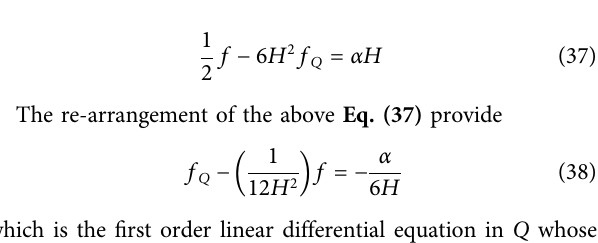
FIGURE 2 | Plot of reconstructed ghost dark energy f ( Q ) gravity model versusnon-metricityparameterfortheappropriatechoiceofconstants c =0.1 and c 1 = 3.0.